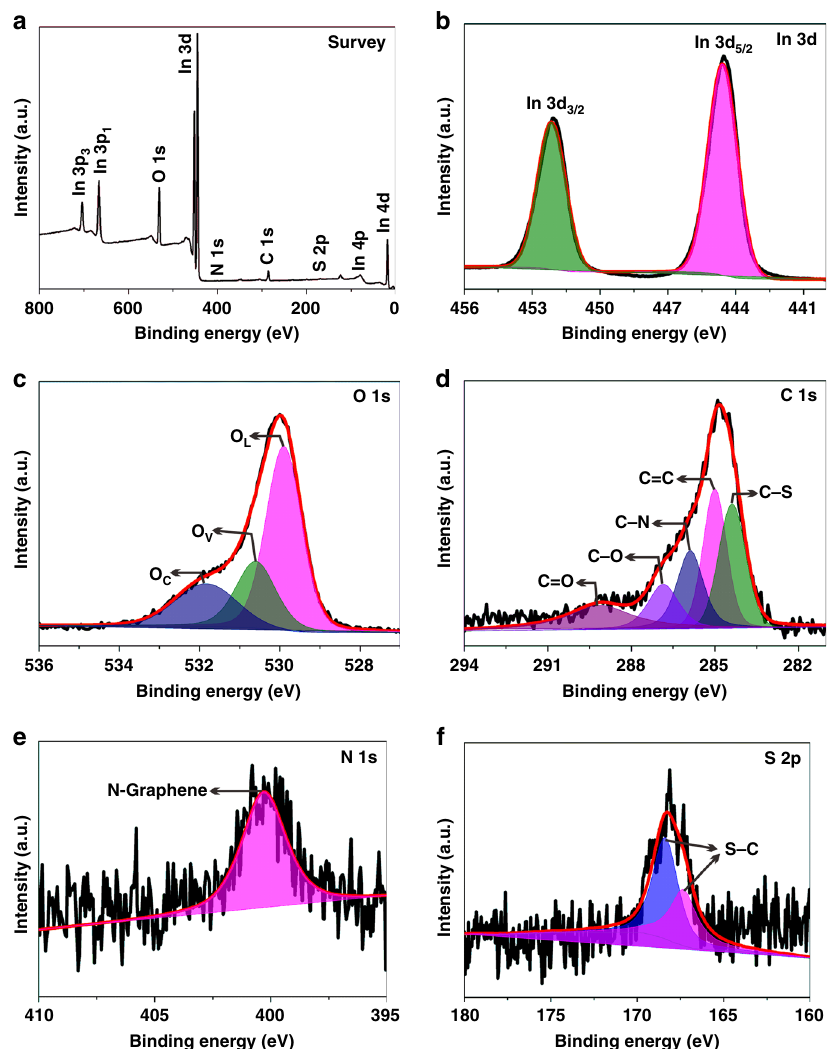
Fig. 3 XPS spectra of N,S-C/In 2 O 3 DHR. a Survey spectrum, and high-resolution spectra of b In 3d, c O 1s, d C 1s, e N 1s, and f S 2p. Source data are provided as a Source Data fi